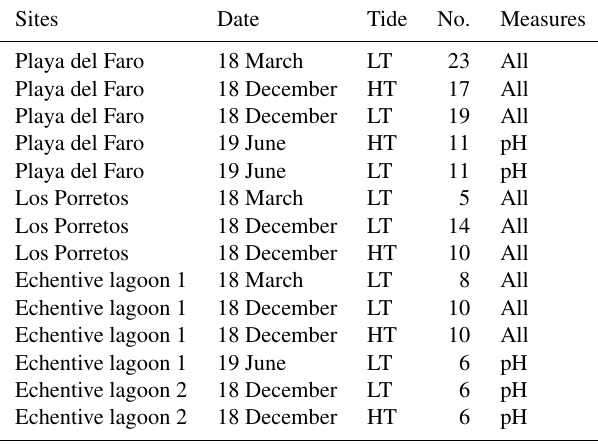
Table A1. Summary of the sampling methodology, with the locations sampled (Sites), the date of each sampling (Date), whether the sampling was performed during the low (LT) or high (HT) tide, and whether the parameters measured (Measures) were all (ALL) or only the pH (pH).